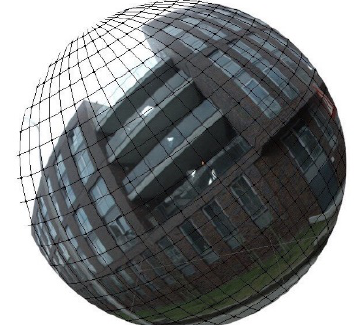
Figure 2. A panoramic image on a sphere. The lines represent latitude and longitude.